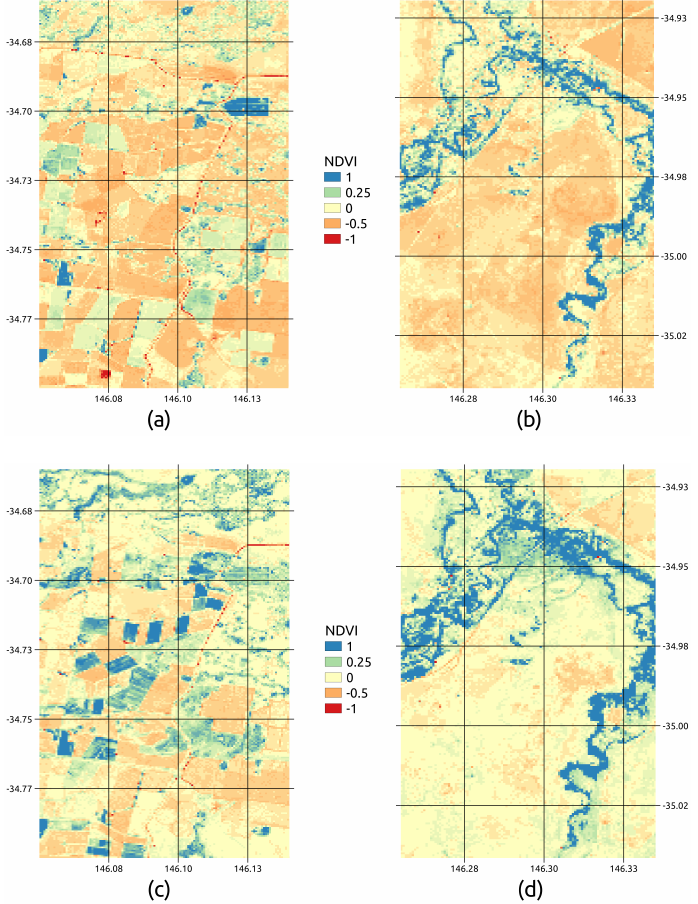
Figure 3. Normalized difference vegetation index (NDVI) retrieved by Sentinel-2. The selected data sets contain Copernicus Sentinel data corresponding to 2018-05-01 (Dry) and 2018-06-16 (Wet) from the Sentinel Hub [51]. Dry flight at ( a ) Site A, and ( b ) Site B; and during Wet flight at ( c ) Site A, and ( d ) Site B. Note that negative NDVI values in ( a , c ) correspond to the Coleambally